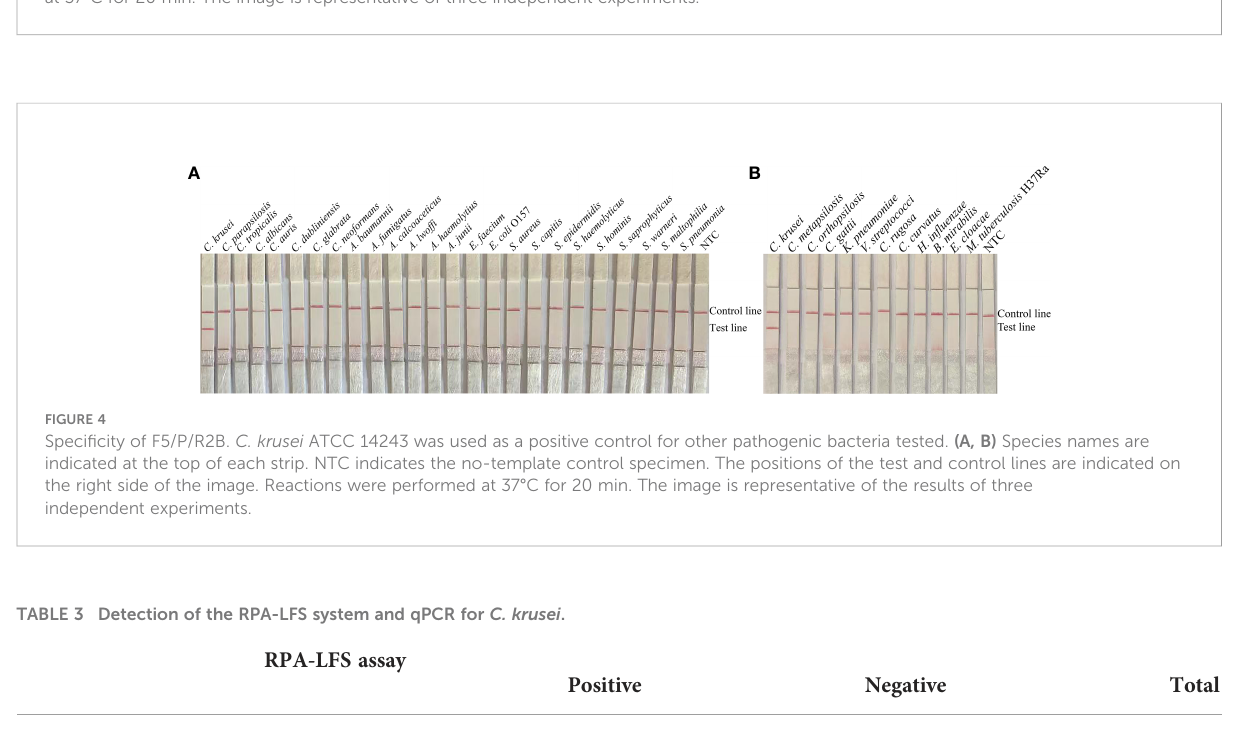
FIGURE 3 Validation of the speci fi city of primer pair F5/P/R2B toward C. krusei . #1 – #20 refer to 20 isolates of C. krusei from clinical specimens; NTC indicates no-template control. The positions of the test and control lines are marked on the right side of the image. Reactions were performed at 37°C for 20 min. The image is representative of three independent experiments.